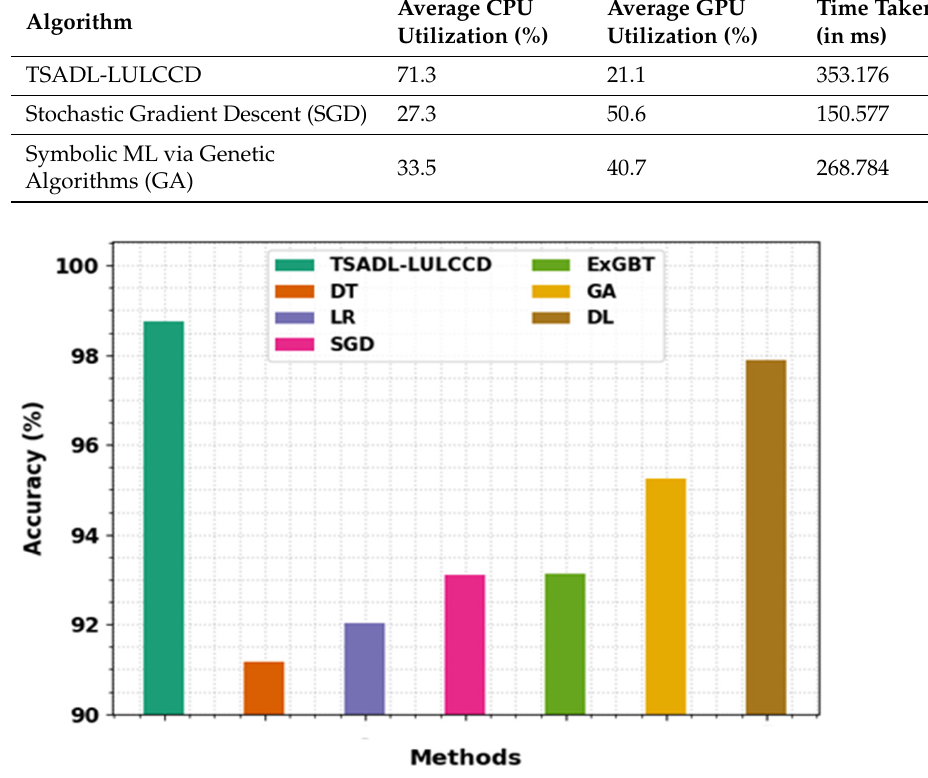
Figure 15. Accu y analysis of TSADL-LULCCD approach with other Figure 15. 𝐴𝑐𝑐𝑢 (cid:3052) analysis of TSADL-LULCCD approach with other approaches.